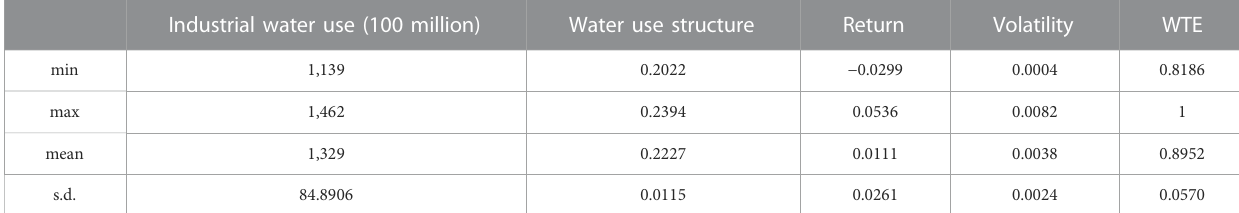
TABLE 2 Descriptive statistics for China. Industrial water use (100 million)